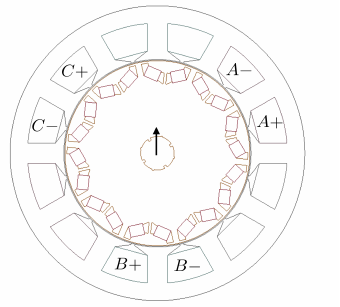
Figure 7. Shift direction of the static eccentricity fault.